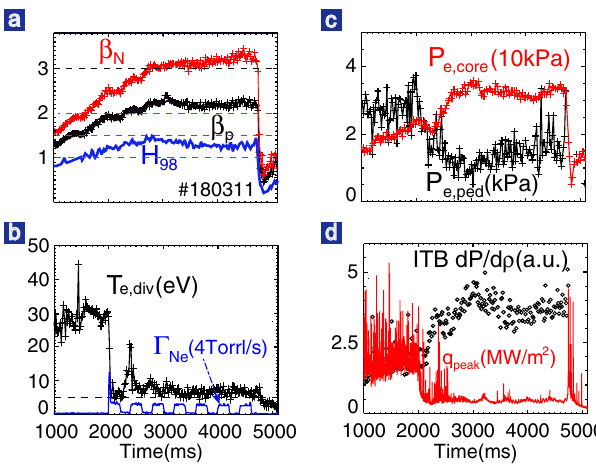
Fig. 6 The peak pressure gradient at the ITB region versus the pedestal pressure, showing that a strong ITB is associated with a weak pedestal. Nitrogen (green circle), neon (red triangle), and D 2 (blue) are shown.